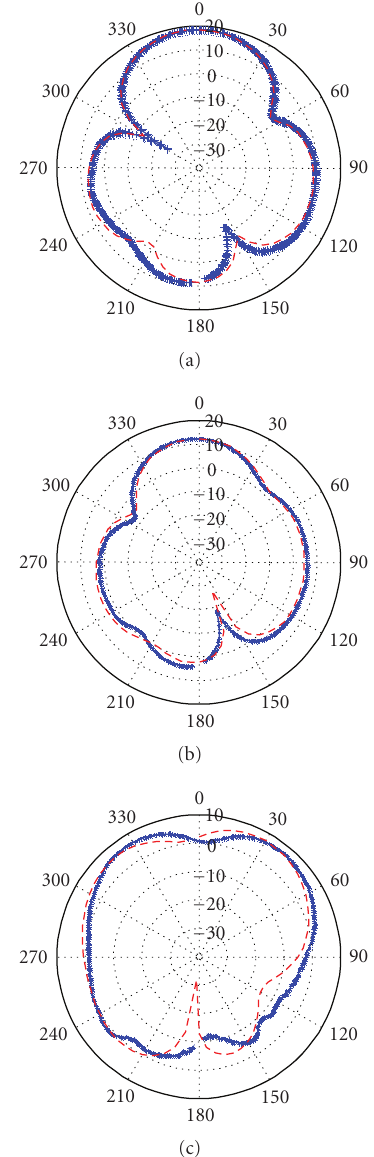
Figure 4: Measured (+) and simulated ( − ) copolarized radiation patterns for broadside mode ( S 11) in XZ-plane at (a) 1.7 GHz, (b) 1.85 GHz, and (c) 2.1